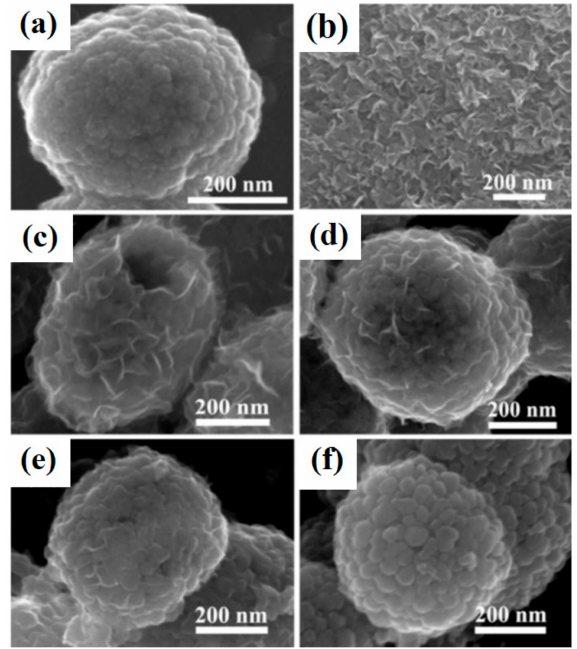
Figure 7. SEM images of ( a ) TiO 2 ; ( b ) MoS 2 ; ( c ) TM3; ( d ) TM6; ( e ) TM9 and (f) TM12 (created